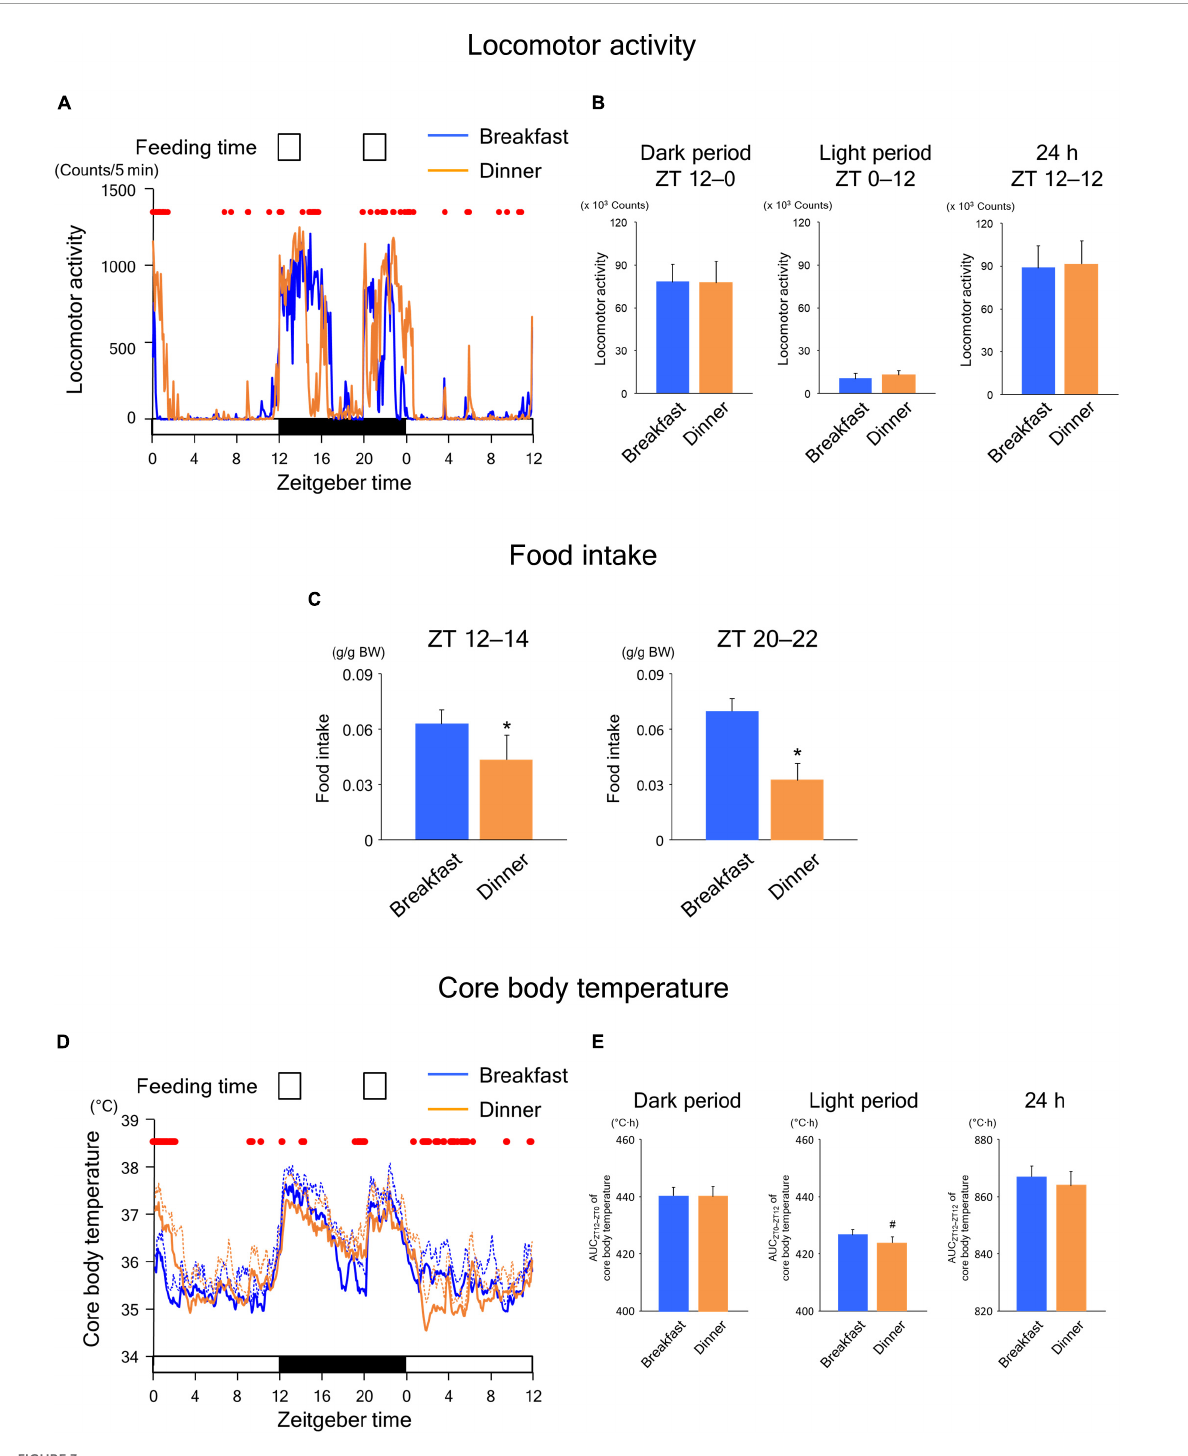
FIGURE3 Sustained effects of time-restricted feeding on locomotor activity (A,B) , food intake (C) , and CBT (D,E) on days 18–19 in wild-type mice. (A) Daily profiles of locomotor activity. Data are medians of five mice. Red dots indicate P < 0.05 between the groups at each time point. (B) Amounts of locomotor activity during the dark period on day 18, light period on day 19, and the total 24-h period. Data are means + SD of five mice. (C) Food intake. Data are means + SD of five mice. * P < 0.05. (D) Daily profiles of CBT. Solid and dotted lines indicate means and means + SD, respectively, of five mice. Red dots indicate P < 0.05 between the groups at each time point. (E) AUC of CBT during the dark period on day 18, light period on day 19, and the total 24-h period. Data are means + SD of five mice. # P <